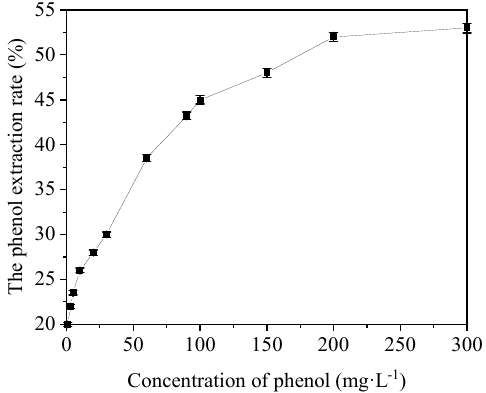
Figure 9. Effect of phenol concentration on phenol extraction rate.